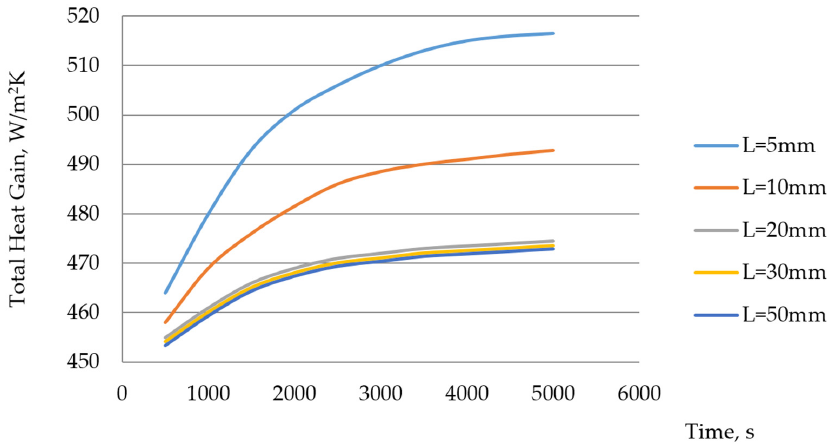
Figure 9. The impact of the gap width on the total heat gain of a ventilated double-pane window (data obtained as a result of processing cited papers).